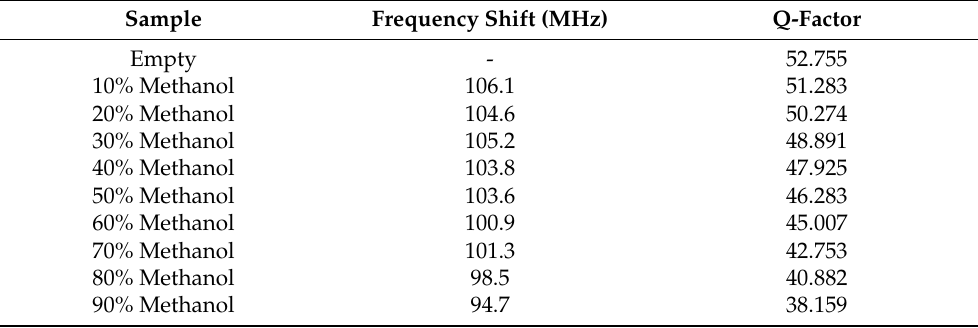
Table 6. The resonant frequency and Q-factor of different concentrations of methanol-water solution.